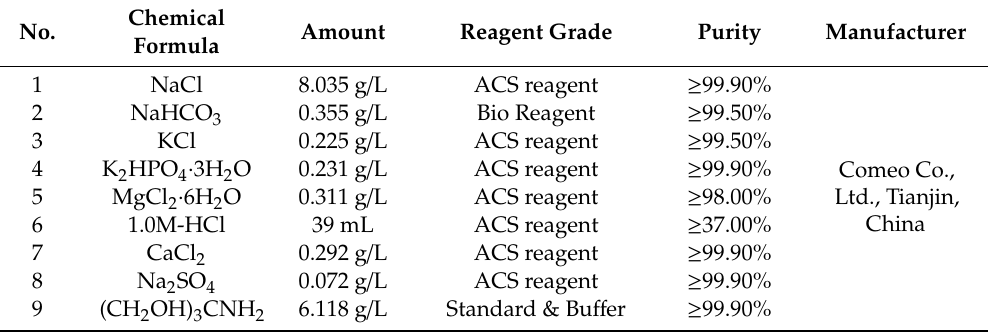
Table 1. Chemical composition and reagents grade (ACS, American Chemical Society standards) and purity used for preparation of simulated body fluid